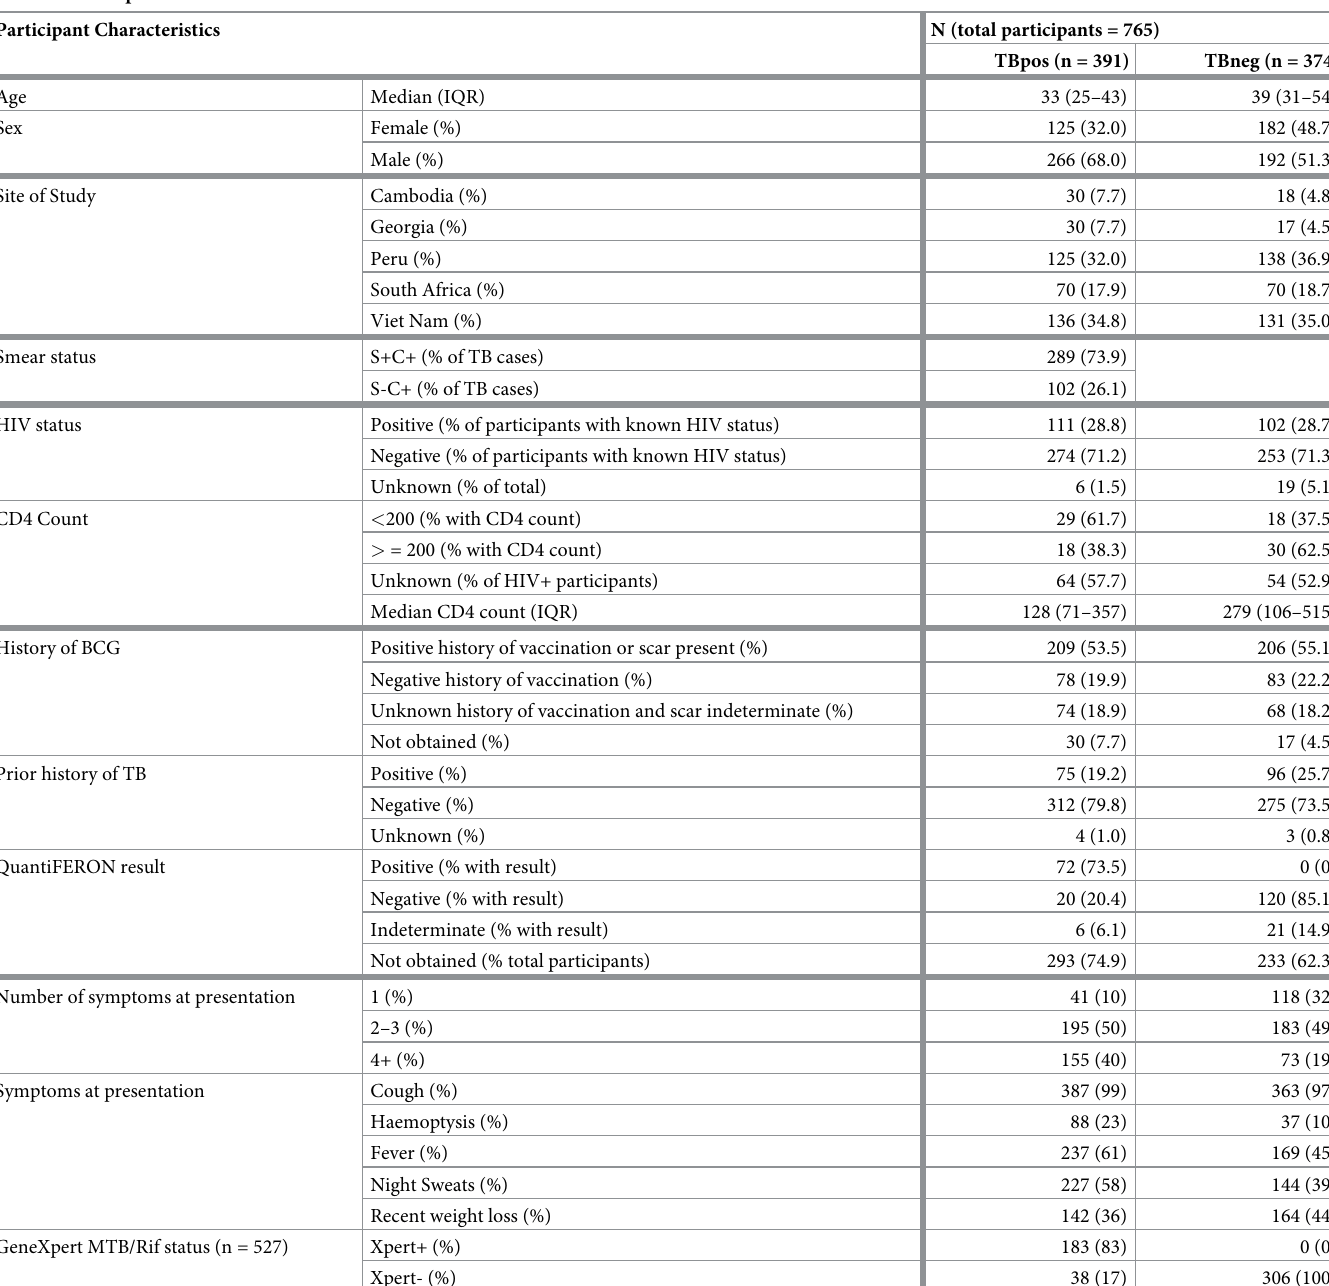
Table 1. Participant